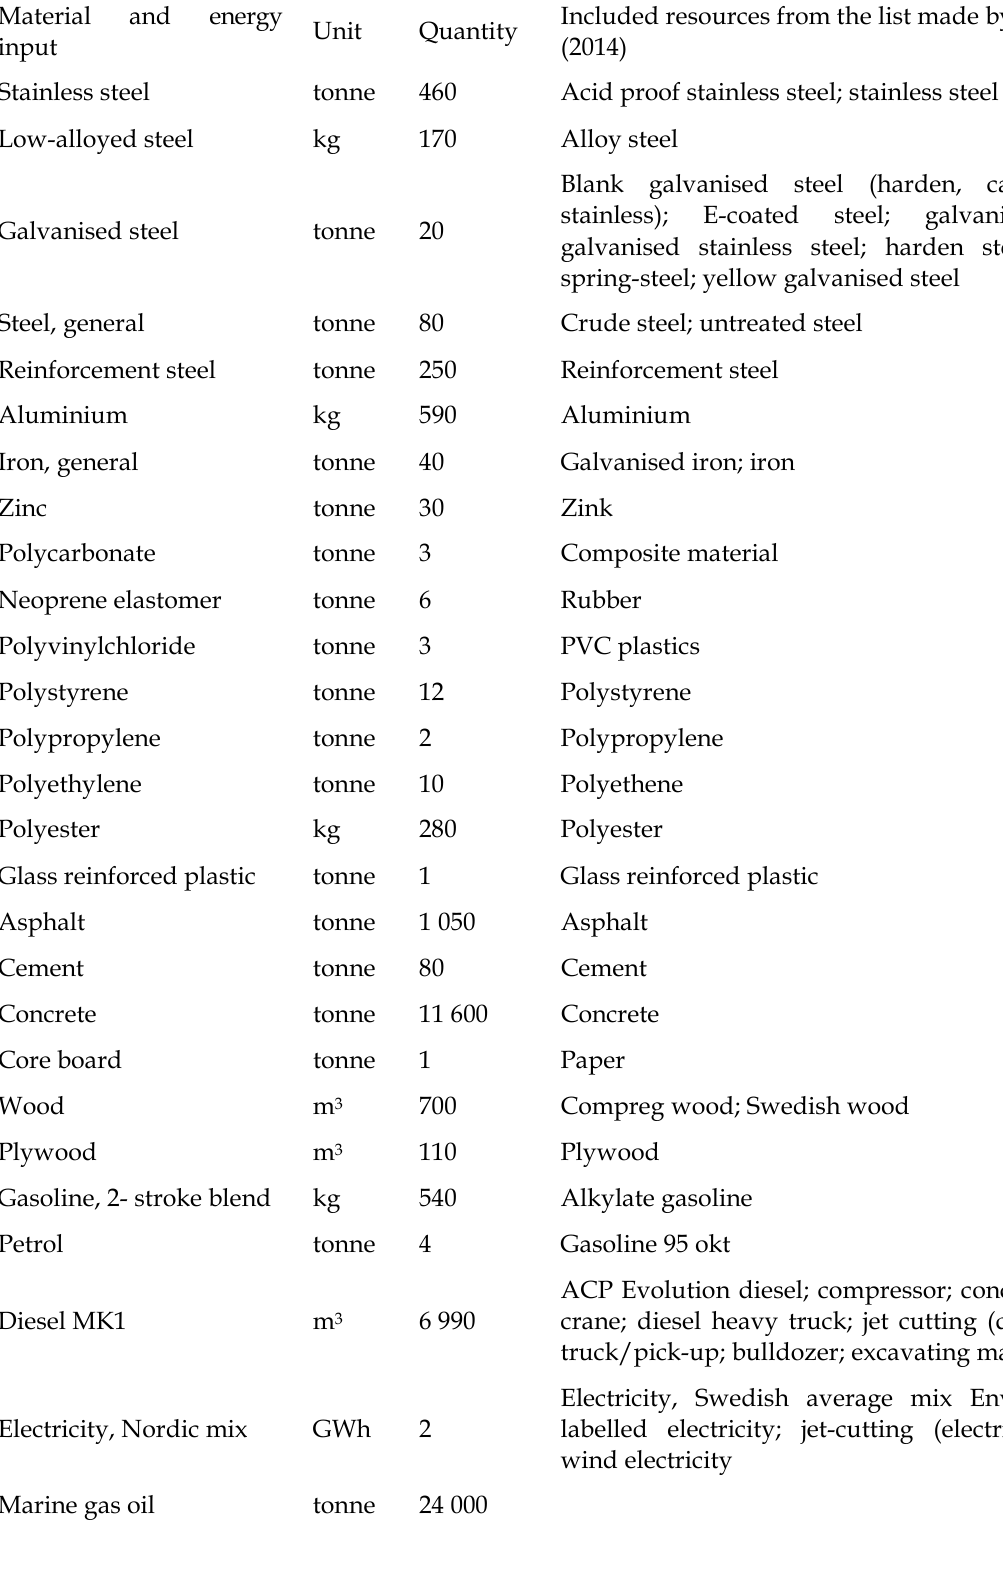
Table A10. New construction maintenance, and reinvestment of sea transport infrastructure: estimated annual material and energy input. Fuel use for vehicles slightly overlaps with fuel use for operation, since the on-site vehicles are used for different